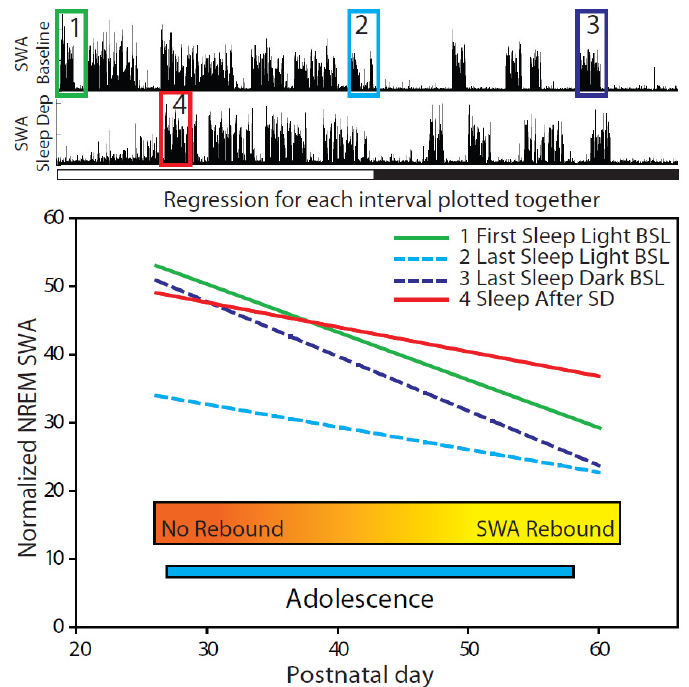
Figure 7. Relationship between age and mean frontal SWA values for 4 daily time points. Plotted is the line of best fit ( f = y + a × x ) ( f = normalized SWA, y = intercept, a = slope 0 0 (SWA/postnatal day), x = Postnatal day) for each specified interval (Age vs. Normalized NREM SWA) for adolescent mice (P26–56, n = 40). NREM SWA was normalized for the mean power density in the 15–30 Hz range for each day. All lines represent statistically significantly relationships ( p <